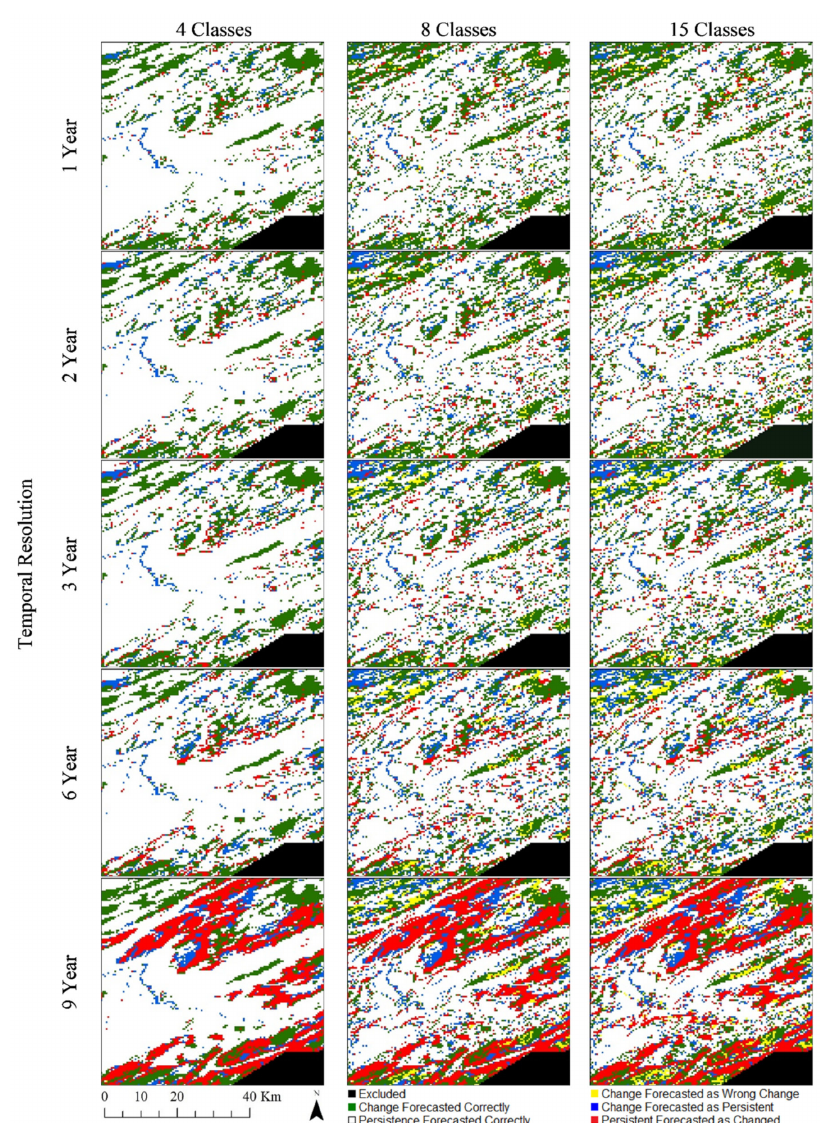
Figure 9. Simulation maps generated outputs from models considering the real-world data. The area shown focusses on the City of